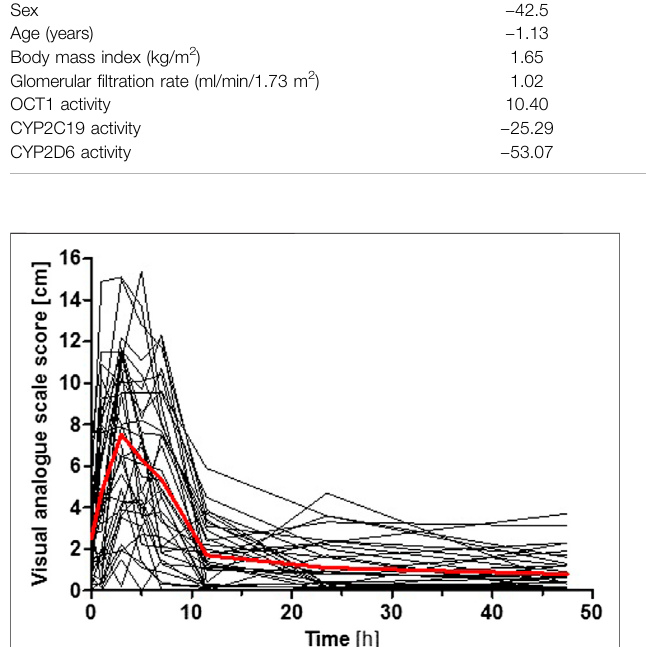
FIGURE 5 | Intensity of fatigue after AT administration reported by the participants using a visual analogue scale. Shown is the time course for each participant (black curves) and the mean superimposed (red curve). The intensity of fatigue was not dependent on OCT1, CYP2D6, or CYP2C19 genotypes ( p > 0.05, Jonckheere-Terpstra